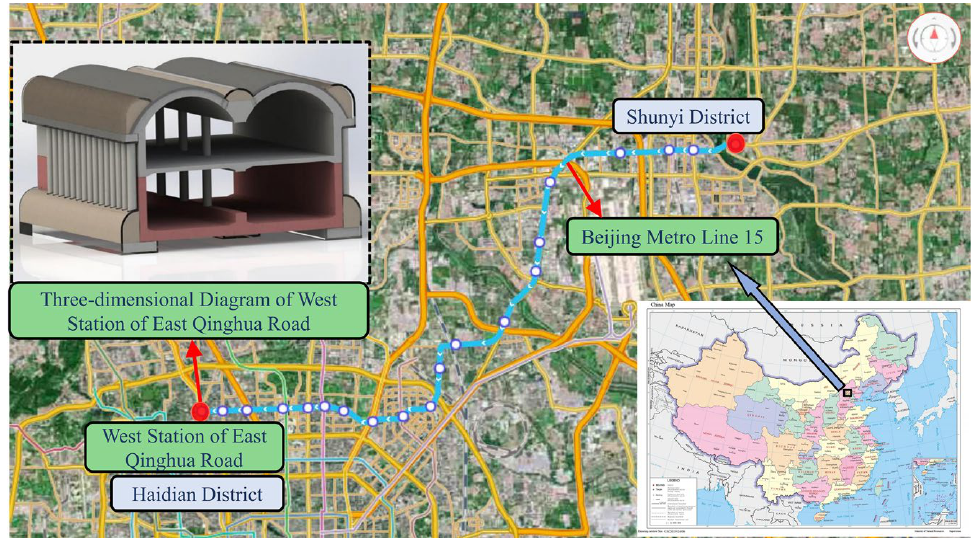
Figure 2. Schematic diagram of the location of Qinghuadongluxikou Station.